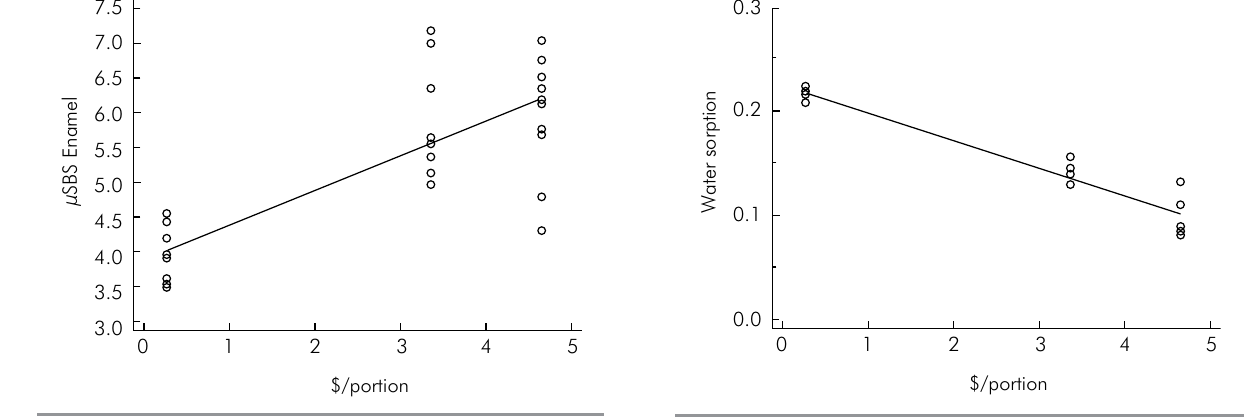
Figure 3. Linear regression: cost versus μSBS in enamel. Figure 5. Linear regression: cost versus water sorption.